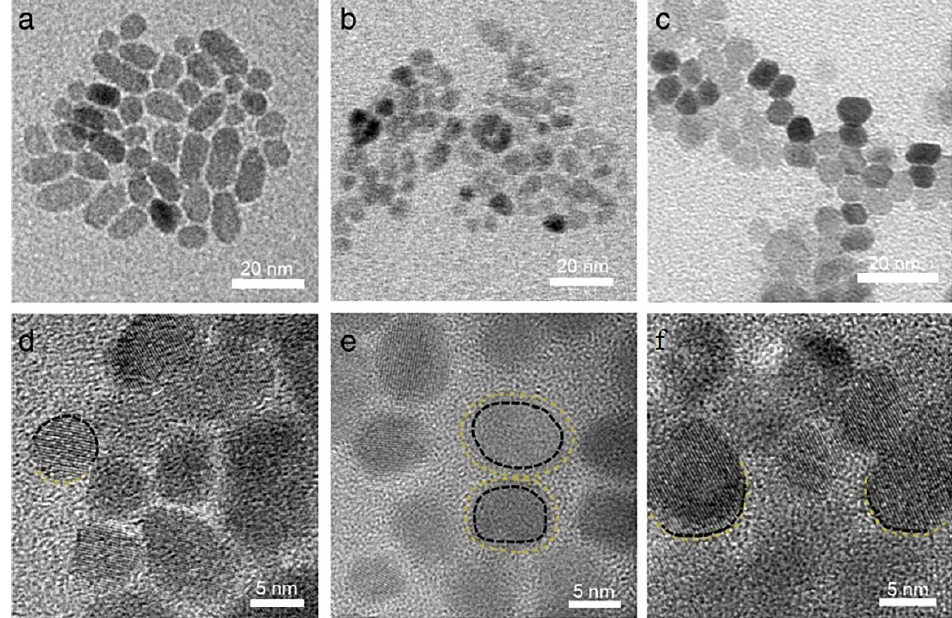
Figure 9. TEM images of ZnO nanoparticles at various growth stages. ( a , d ) Primary nucleation. ( b , e ) flake-like aggregates. ( c , f ) Well-crystallized particles. The figure is reproduced with copyright permission of ref.